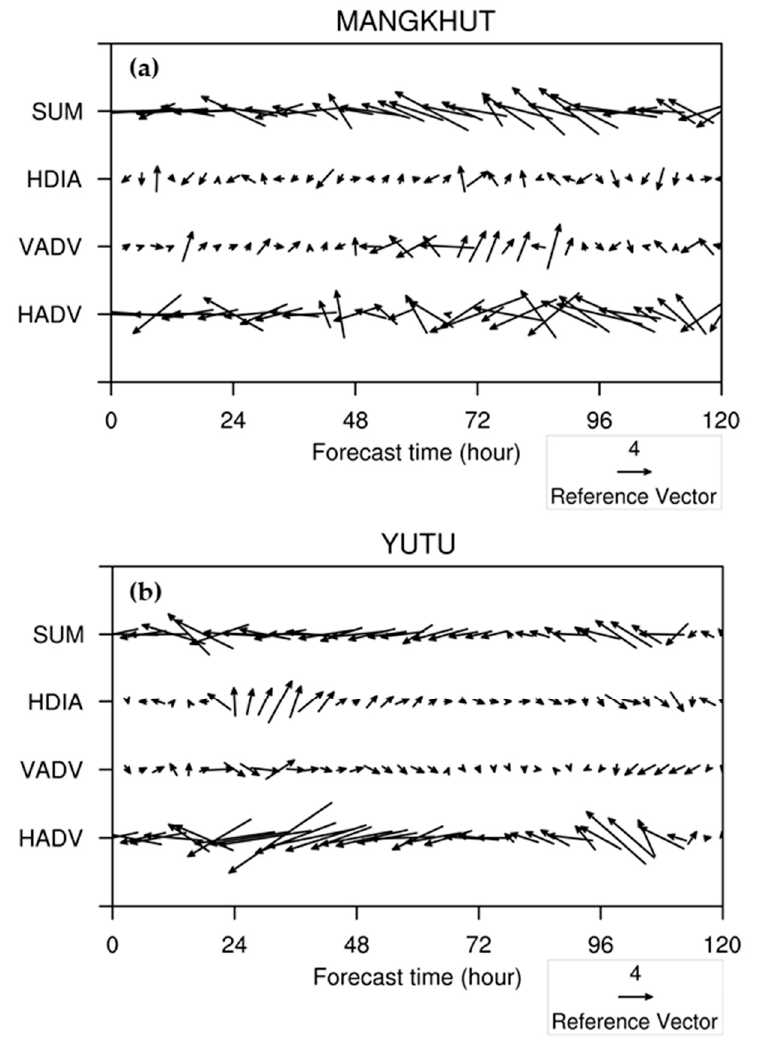
Figure 15. Time evolution of the translation velocity (vector) induced by different PV budget terms during the simulation time of 120 h for ( a ) MK-CTL and ( b ) YT-CTL. HDIA, VADV, HADV, and SUM denote differential diabatic heating, vertical PV advection, horizontal PV advection, and the sum of the former three terms,